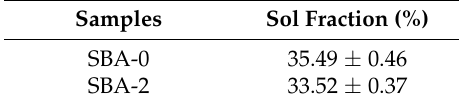
Table 2. Sol fraction of cured SBA-0 and SBA-2.